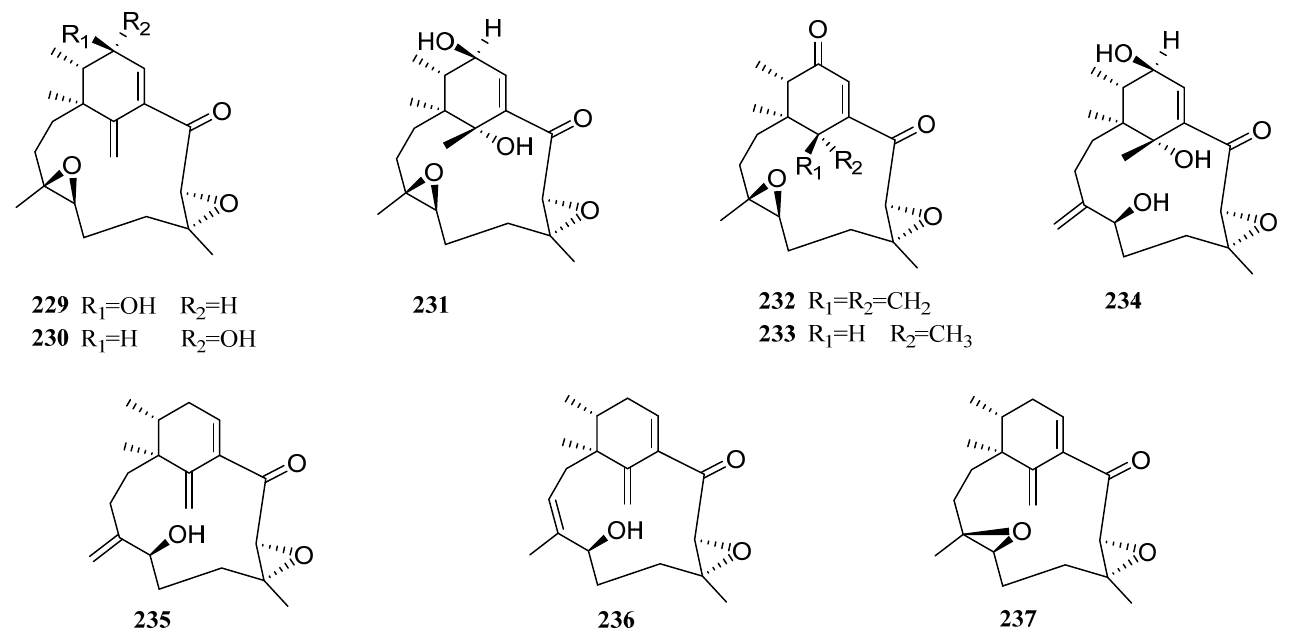
Figure 10. Chemical structures of diterpenes ( 229 – 237 from unidentified fungus).